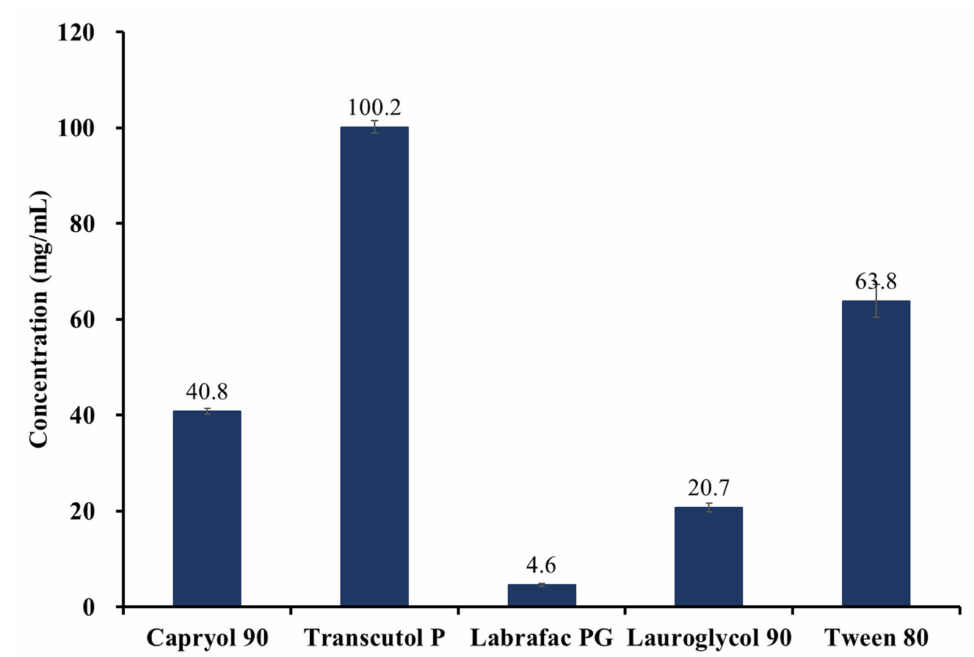
Figure 2. The Solubility of JIN-001 in various oils ( n =